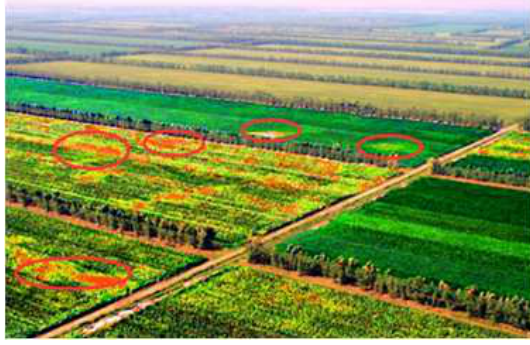
Figure 11. The analysis results of pests for a UAV image.